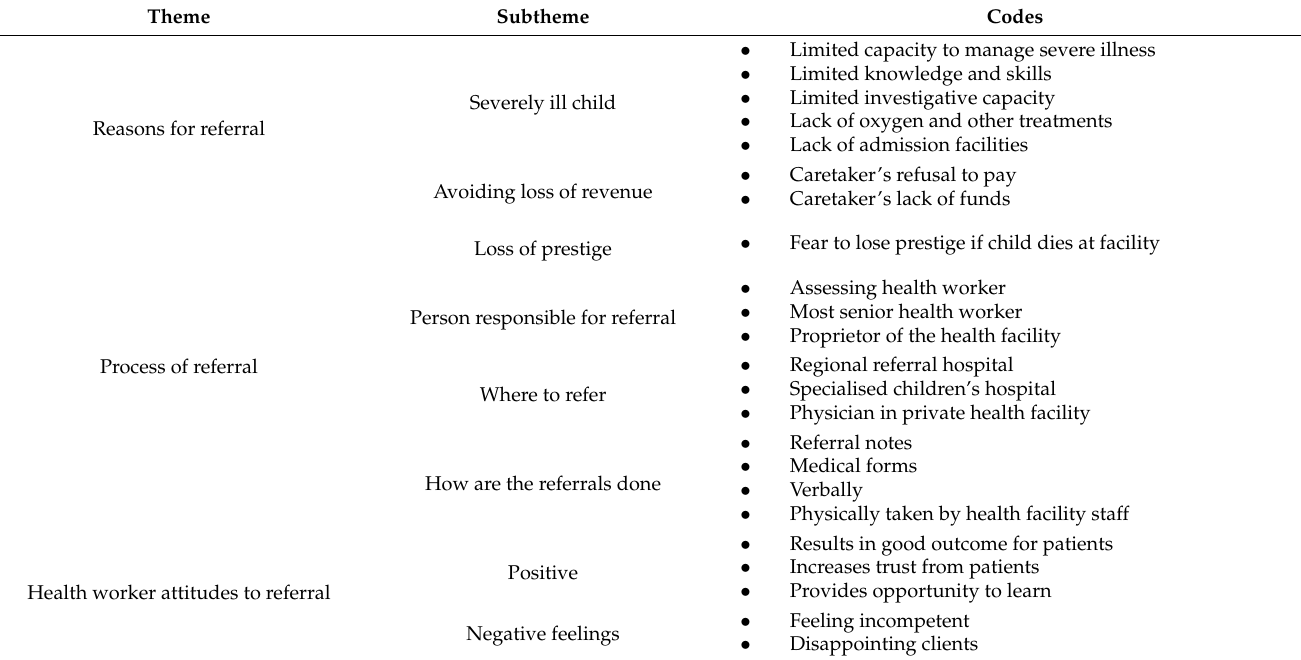
Table 3. Summary of the themes and subthemes for the referral